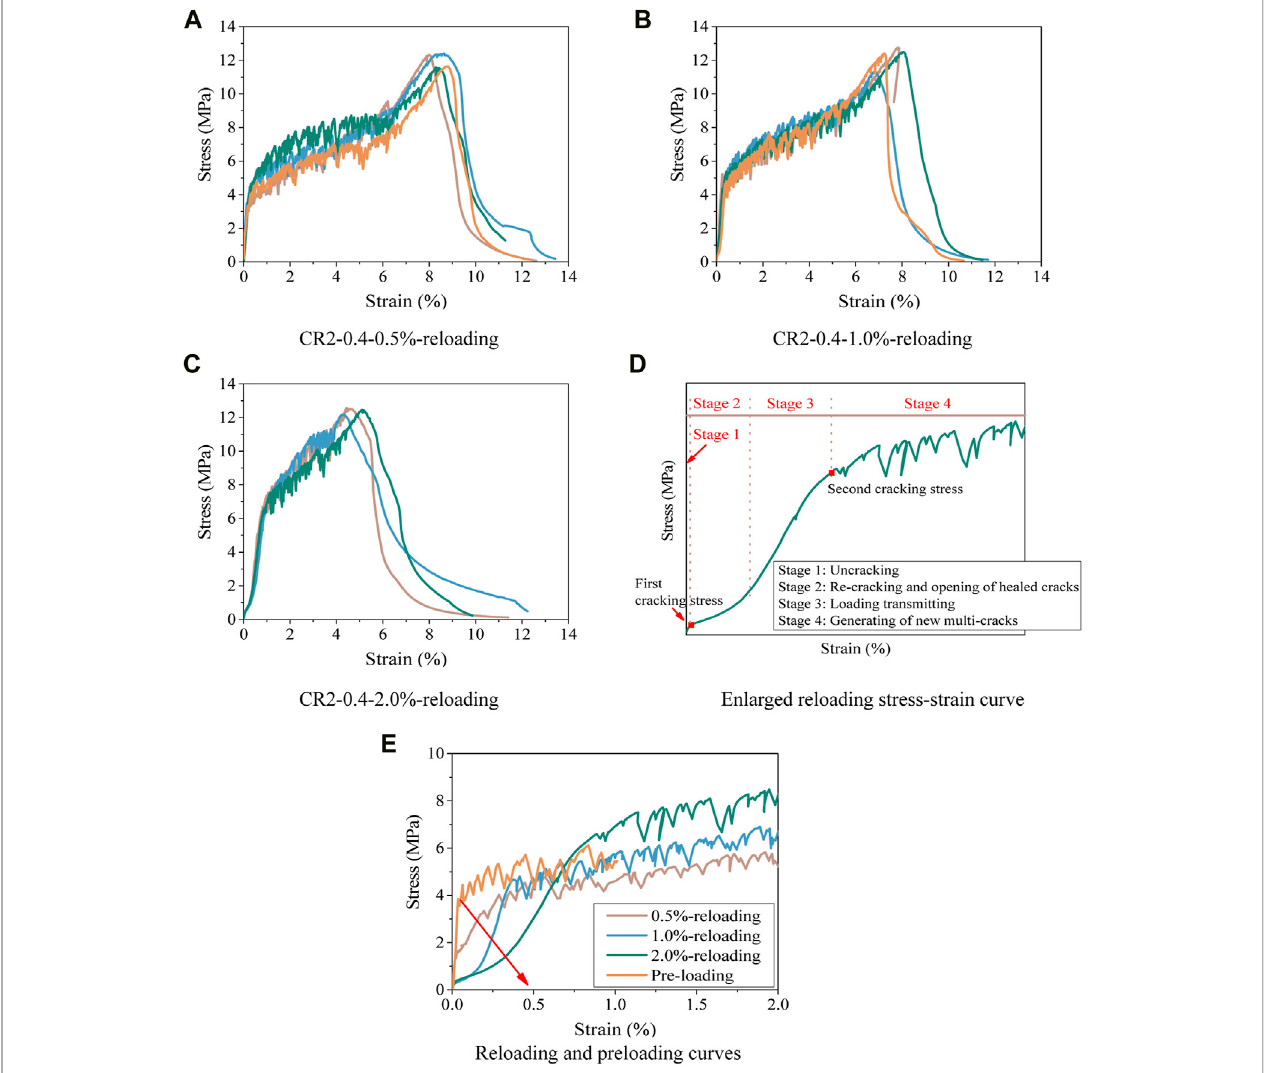
FIGURE 10 | Stress – strain curves of self-healed CR2-0.4 specimens. (A) CR2-0.4-0.5%-reloading. (B) CR2-0.4-1.0%-reloading. (C) CR2-0.4-2.0%-reloading. (D) Enlarged reloading stress – strain curve. (E) Reloading and preloading curves.